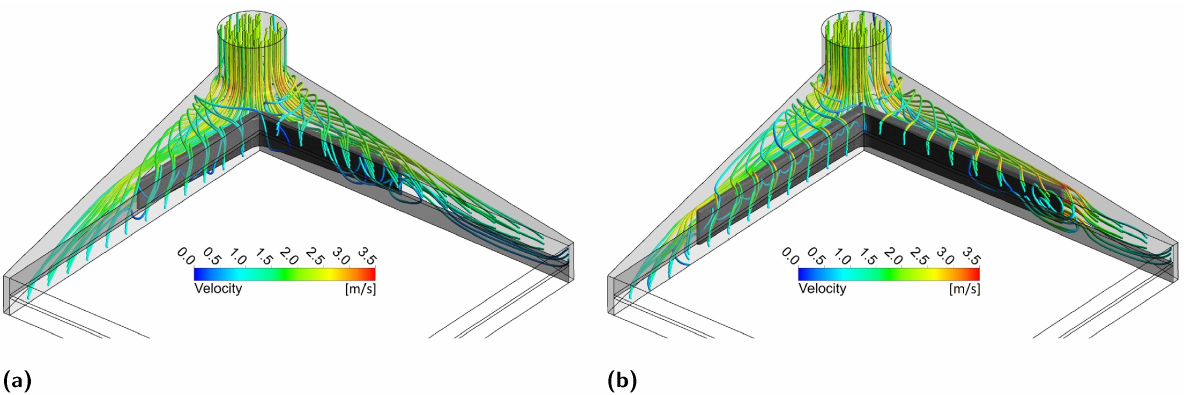
Figure 9. Header with cut baffle: pathlines in the inlet header for u ave = 1.0 m/s, colored by velocity magnitude for ( a ) L b = 4.5 mm and 75% cut height (case C1-L3) and ( b ) L b = 4.5 mm and 90% cut height (case